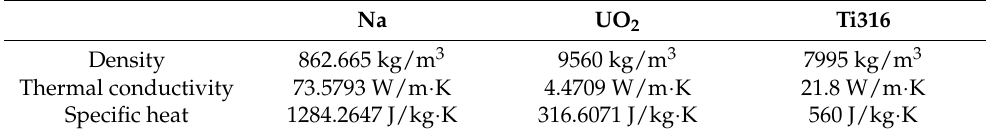
Table 5. Physical properties.